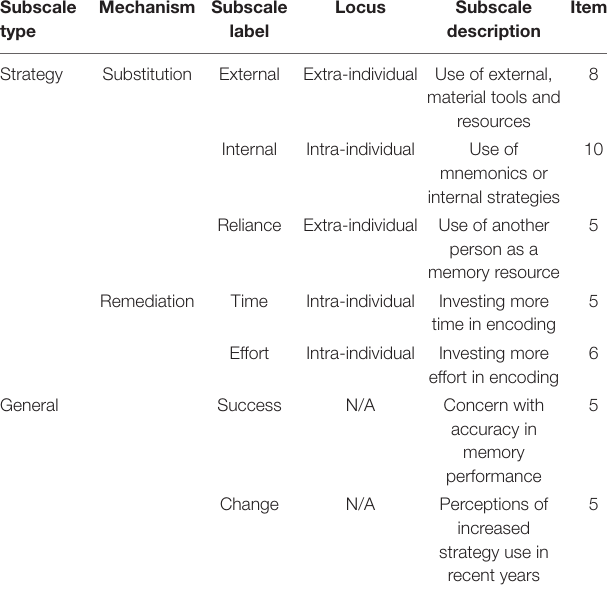
TABLE 1 | Classification of subscales in the Memory Compensation